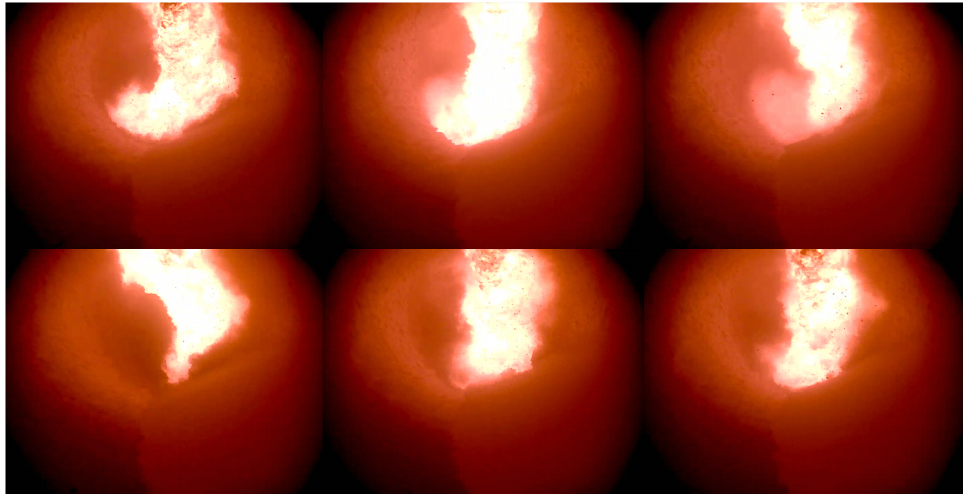
Figure 11. Images recorded in the real process showing the unsteady flame. Figure adapted from [11]. Reprinted with permission from the Society for Mining, Metallurgy &